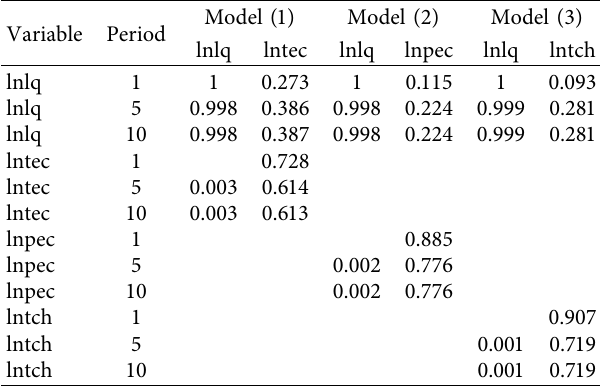
Table 7: Variance decomposition results of each